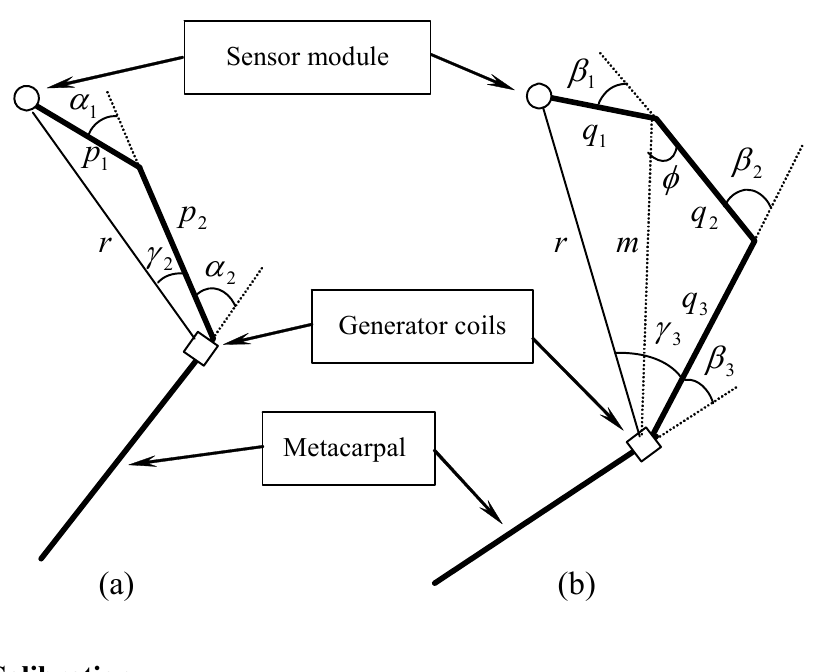
Figure 6. The relationship between the distance r and the bending angles of finger joints: (a) for the thumb; (b) for the other fingers.